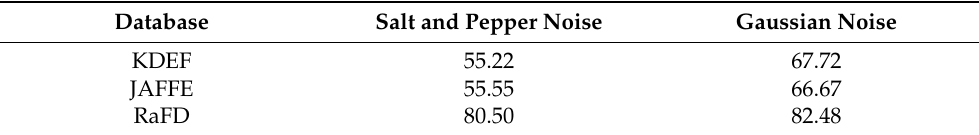
Table 8. Percentage deviation of classification accuracy for each database, with corrupted test files, for the handcrafted